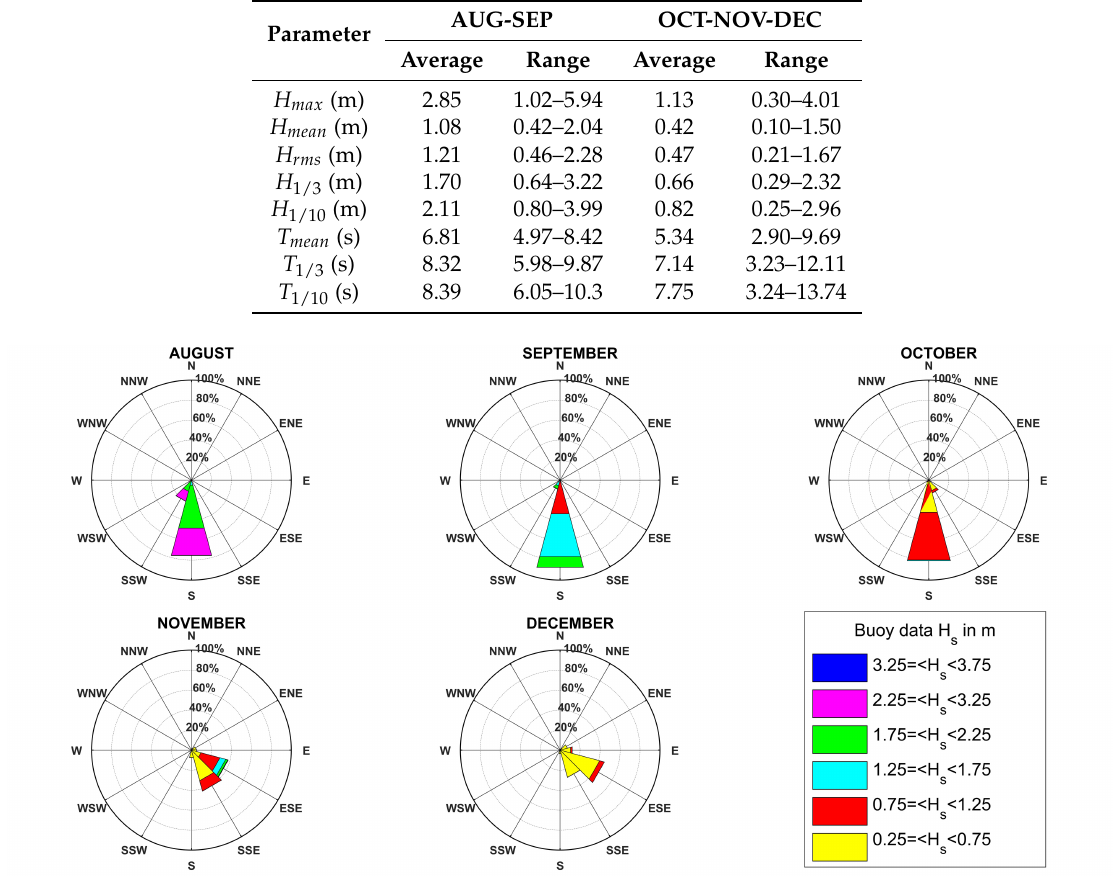
Figure 4. Monthly wave roses. Nautical convention for wave directions (i.e., the direction where the waves come